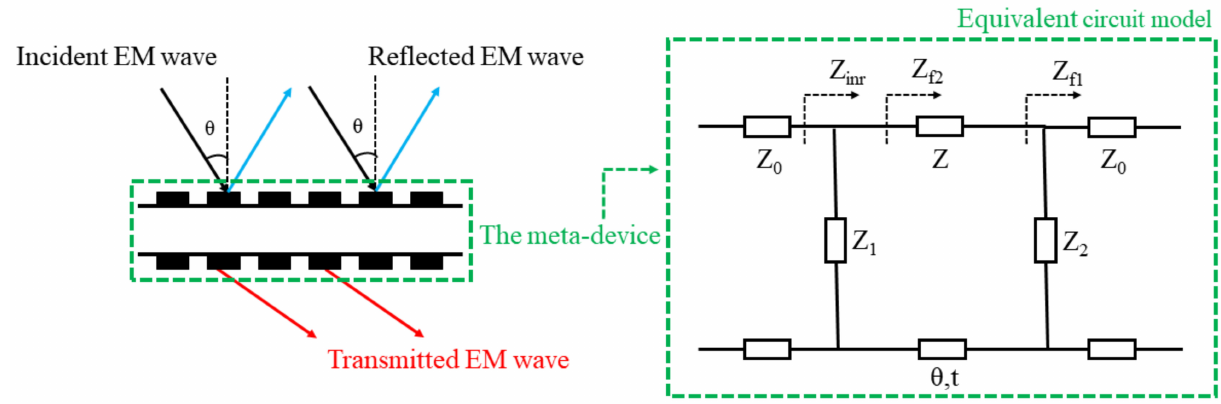
Figure 1. The diagram of the path of action of EM waves and the corresponding equivalent circuit